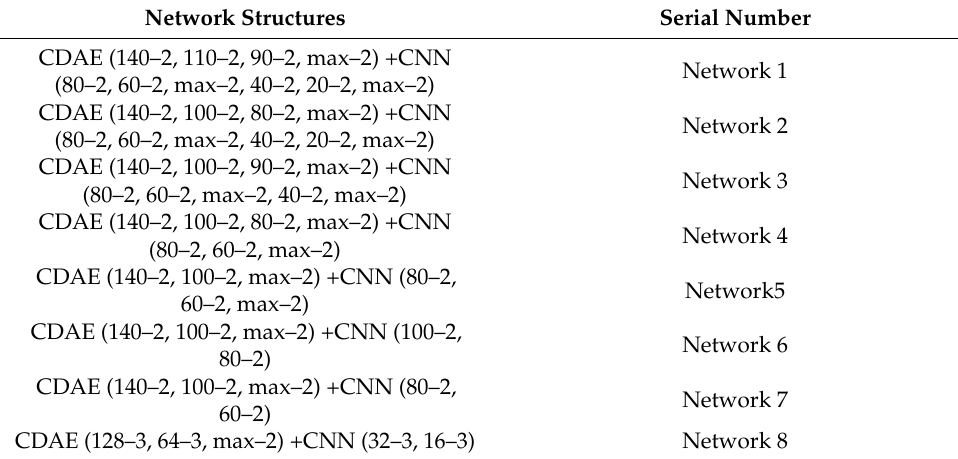
Table 2. Network structure and its sequence number.